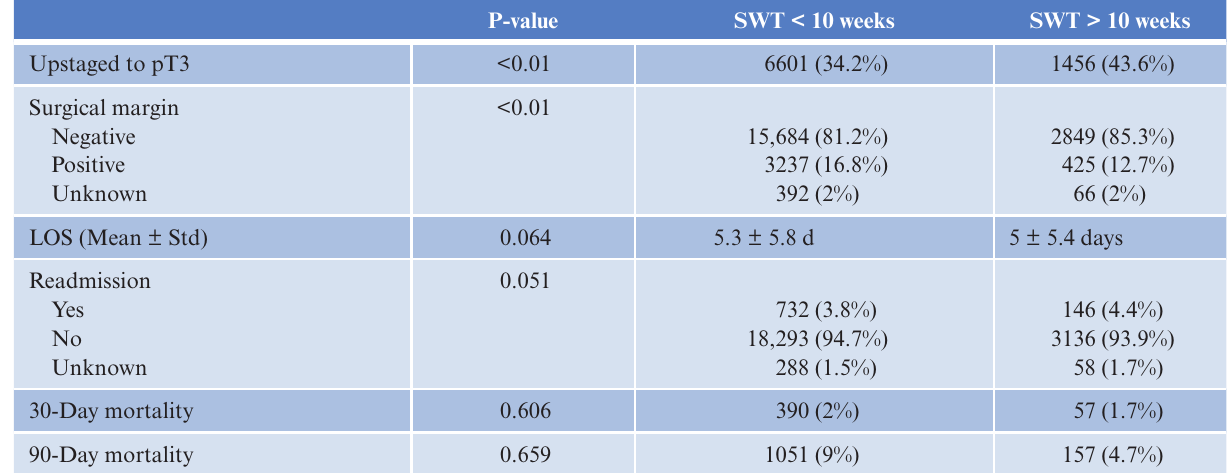
Figure 1: Trend analysis of surgical wait time (SWT) for the study period 2004–2014. Figure demonstrates the median SWT of each year. The Jonckheere–Terpstra test shows a statistically significant trend of increasing SWT from 2004 to Table 2: Treatment outcomes by groups.